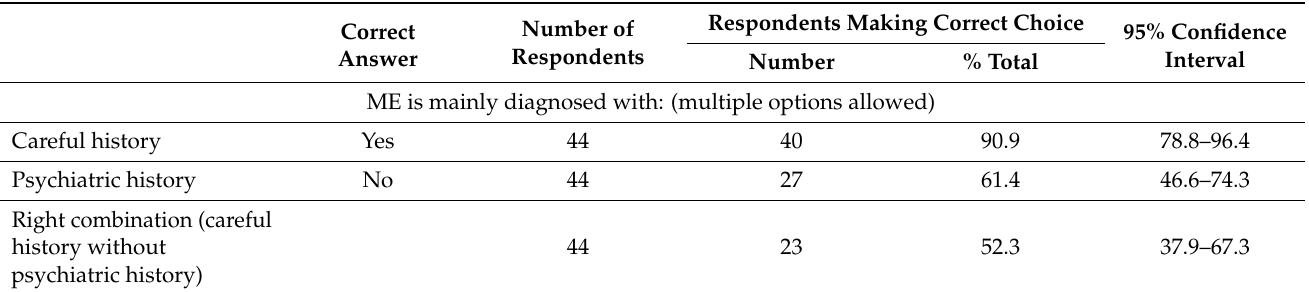
Table 6. Respondents’ views on diagnostic methods.